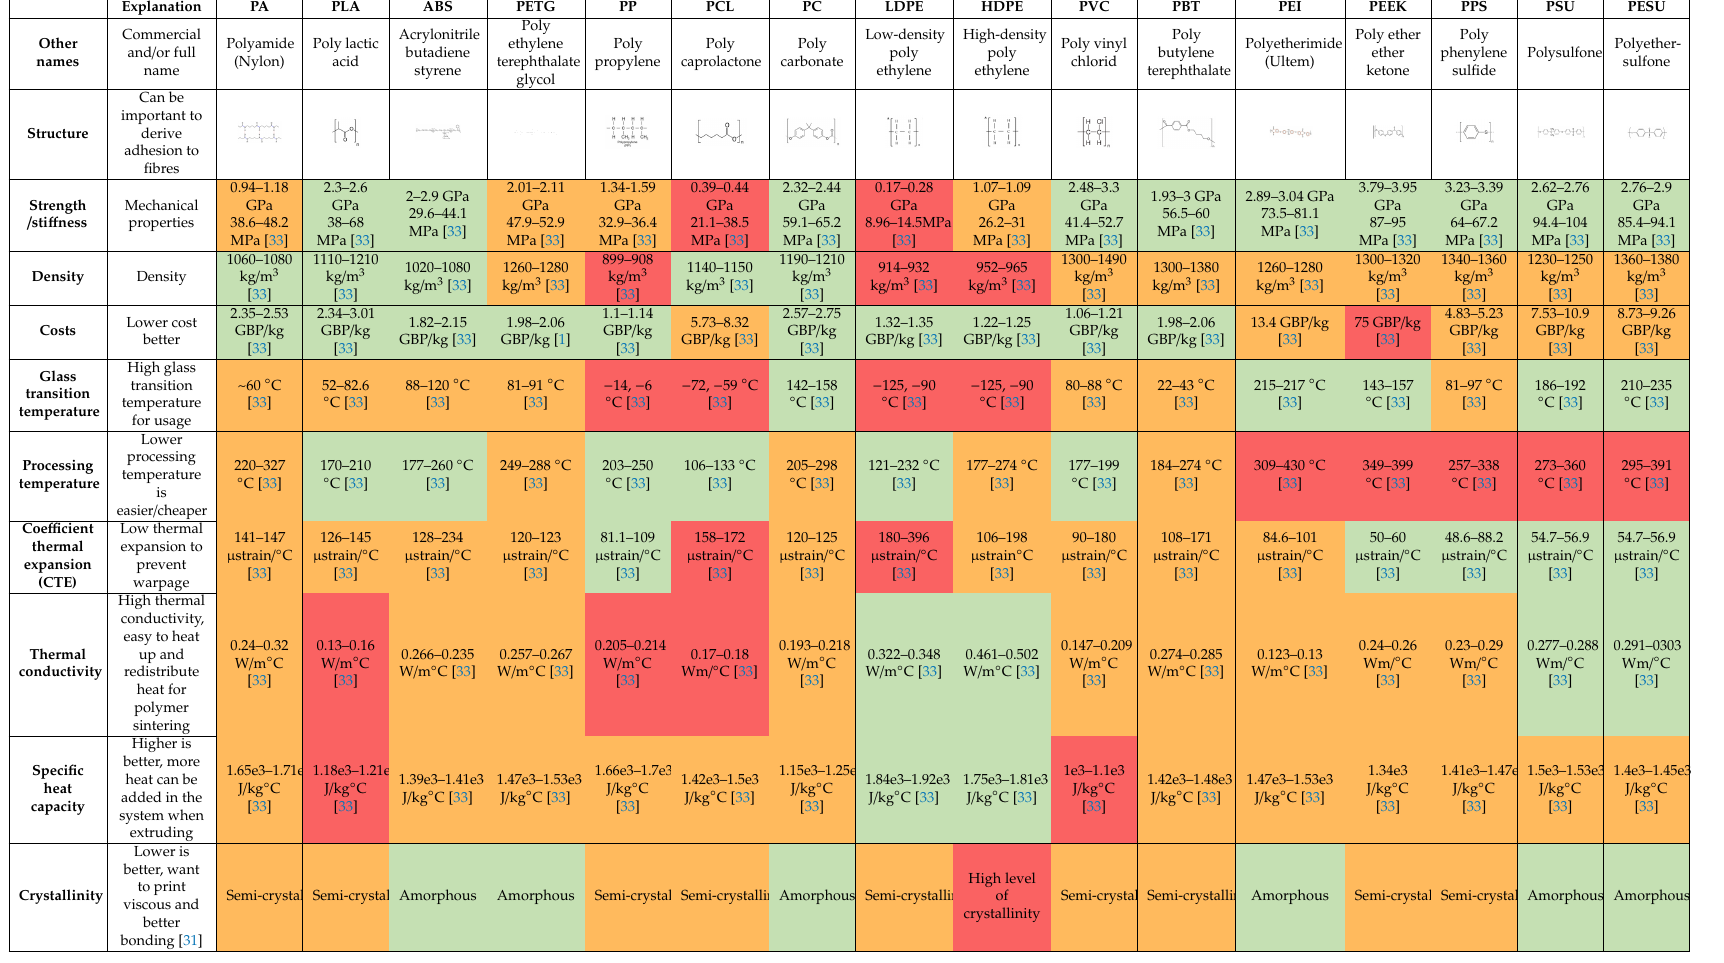
Table 1. Comparison chart for suitability of di ff erent polymer for fibre reinforced 3D printing.